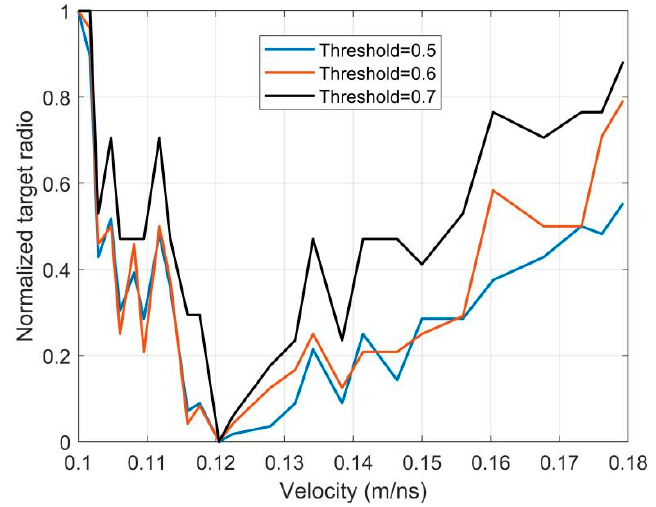
Figure 4. Signal processing results at the velocity of 0.15596 m/ns. ( a ) Vertical slices of the migrated GPR data. ( b ) The standard deviation of cross-correlation. ( c ) Depth slice containing the target. ( d ) Pixels in the migration image slice with values greater than a certain threshold. ( e ) Depth slice con- taining the target with the threshold plane ( ε = 0.5).